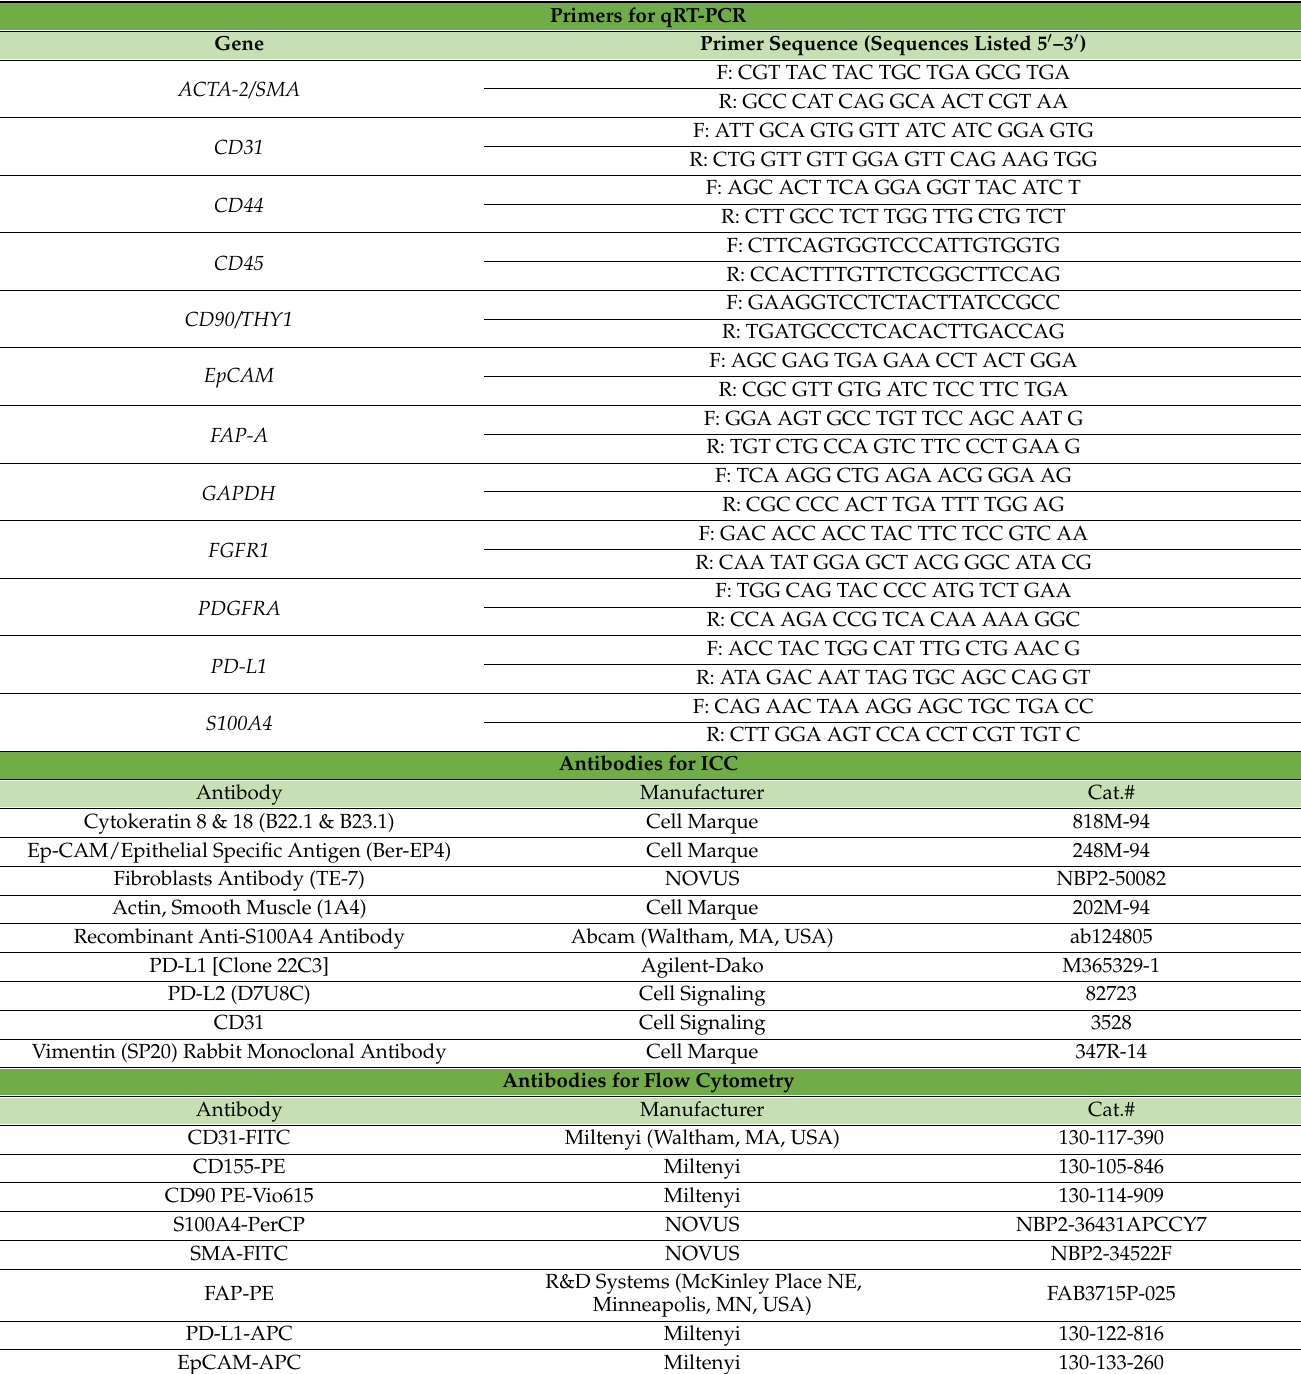
Table 4. Detailed information on the antibodies and primers used in the